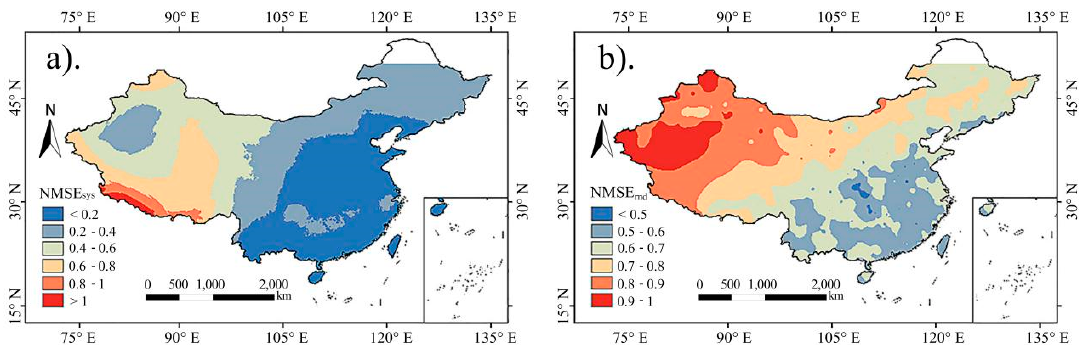
Figure 6. Spatial distribution of the daily NMSE sys ( a ) and NMSE rnd ( b ) of the 3B42V7 data in mainland China.